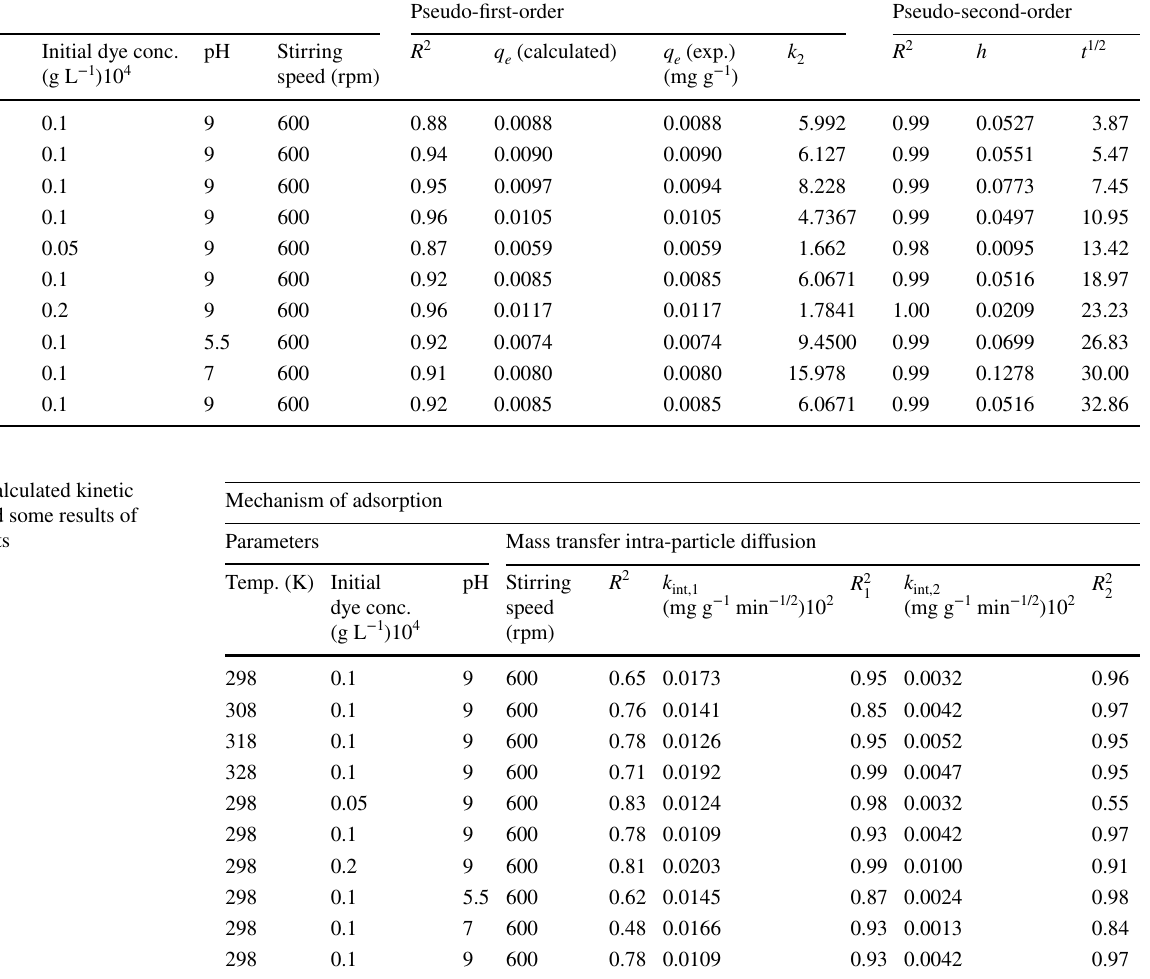
Fig. 6 SEM images of pure polyethylene ( a ), polyethylene with GC ( b ) and the composite with methylene blue ( c ) Table 3 Calculated kinetic models and some results of experiments Kinetic models Parameters Pseudo-first-order